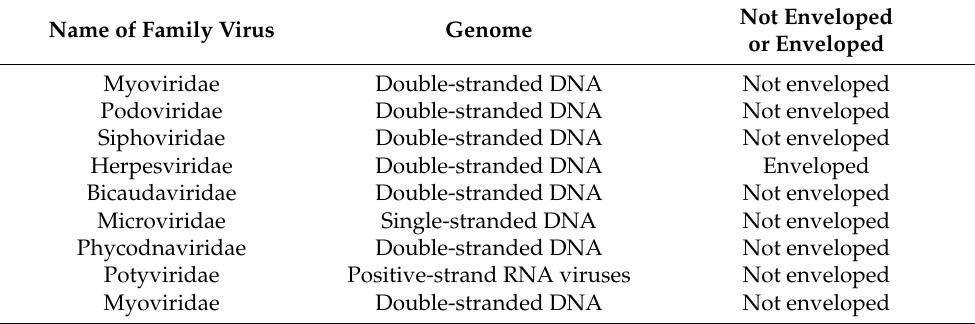
Table 1. Genome and capsid described of family’s virus in brine